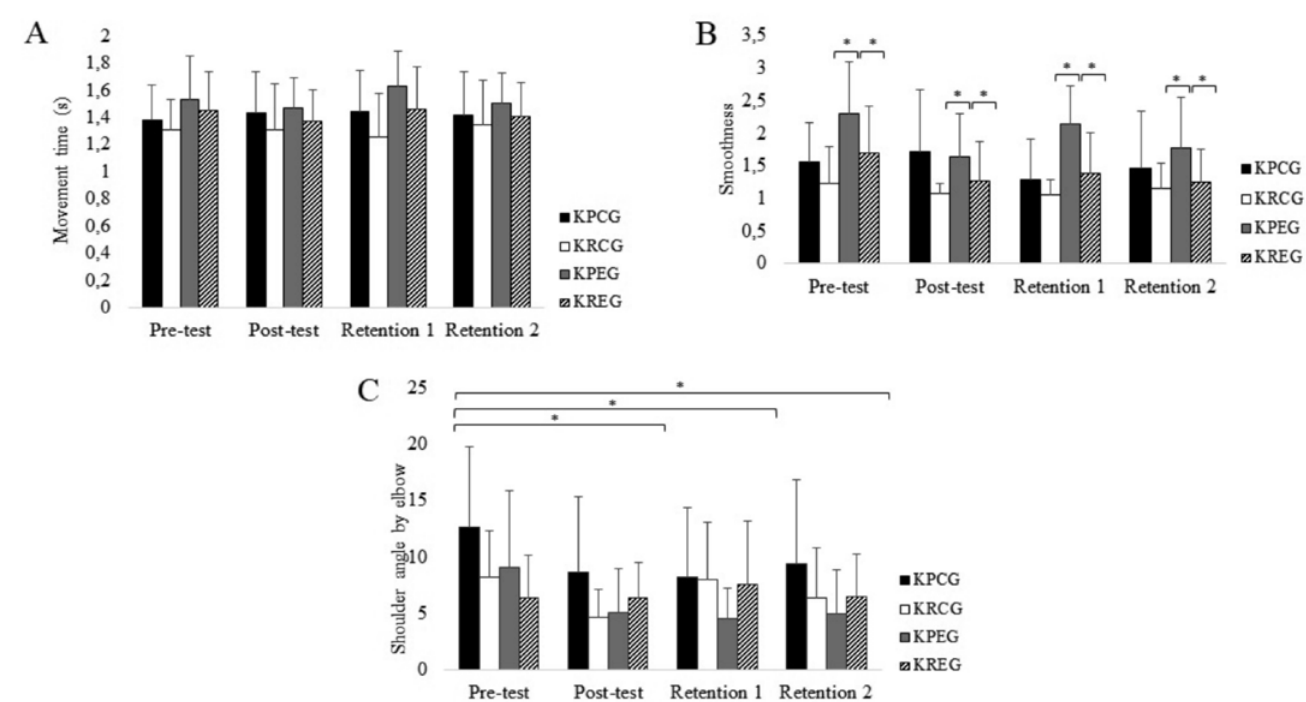
Figure 5A, B, C. KPCG = knowledge of performance control group, KRCG = knowledge of results control group, KPEG = knowledge of performance experimental group, KREG = knowledge of results experimental group, Figure 5B= * = significant difference intergroup. Figure 5C= * = significant difference